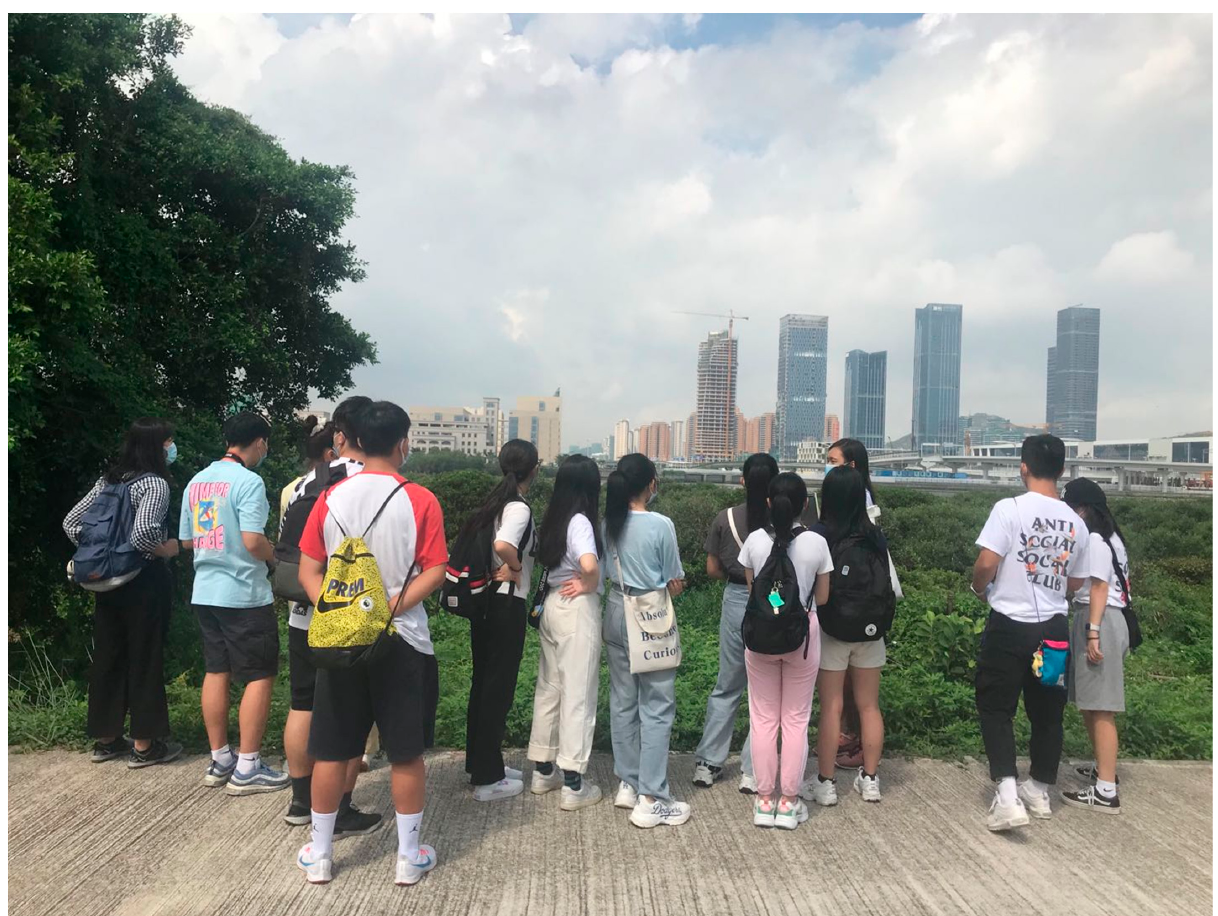
Figure 1. Students viewing the mangroves-related materials at the exhibition gallery.